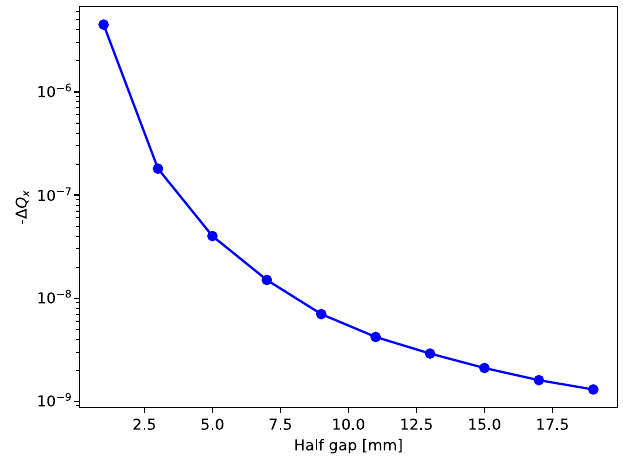
FIG. 11. Estimated horizontal tune shift from the mode m ¼ 0 as a function of jaw half gap at 55 GeV for a bunch charge of 1 . 3 × 10 11 protons and a bunch length of τ